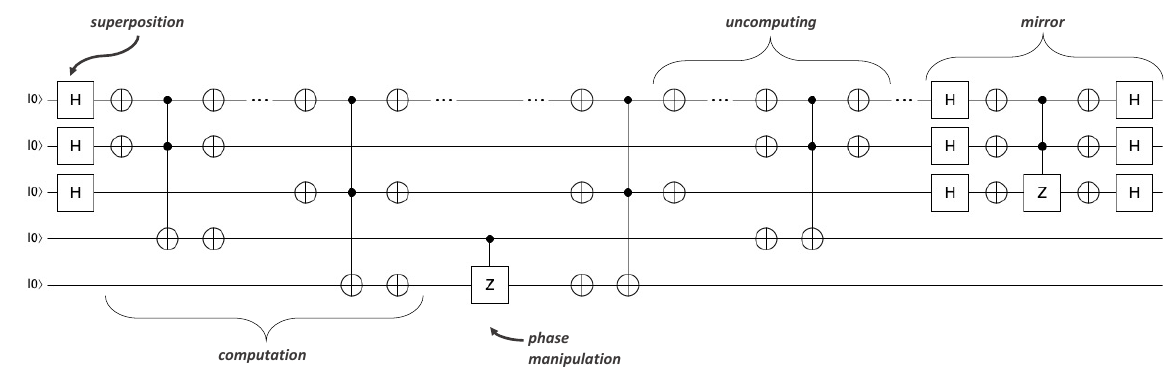
Figure 8. Sample of reusable module for solving a 3-SAT to find whether exists a combination of the three Boolean inputs to evaluate as true a given logic expression (image obtained using the https://algassert.com tool, accessed on 23 June 2021).